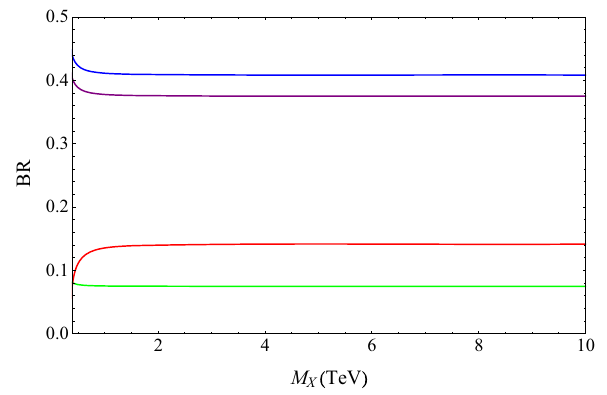
Fig. 2 Branching ratios of the gauge boson X μ as the functions of its mass M X . The green, purple, blue, and red curves correspond to X → ¯ νν , ¯ ll , ¯ qq , ¯ tt , respectively